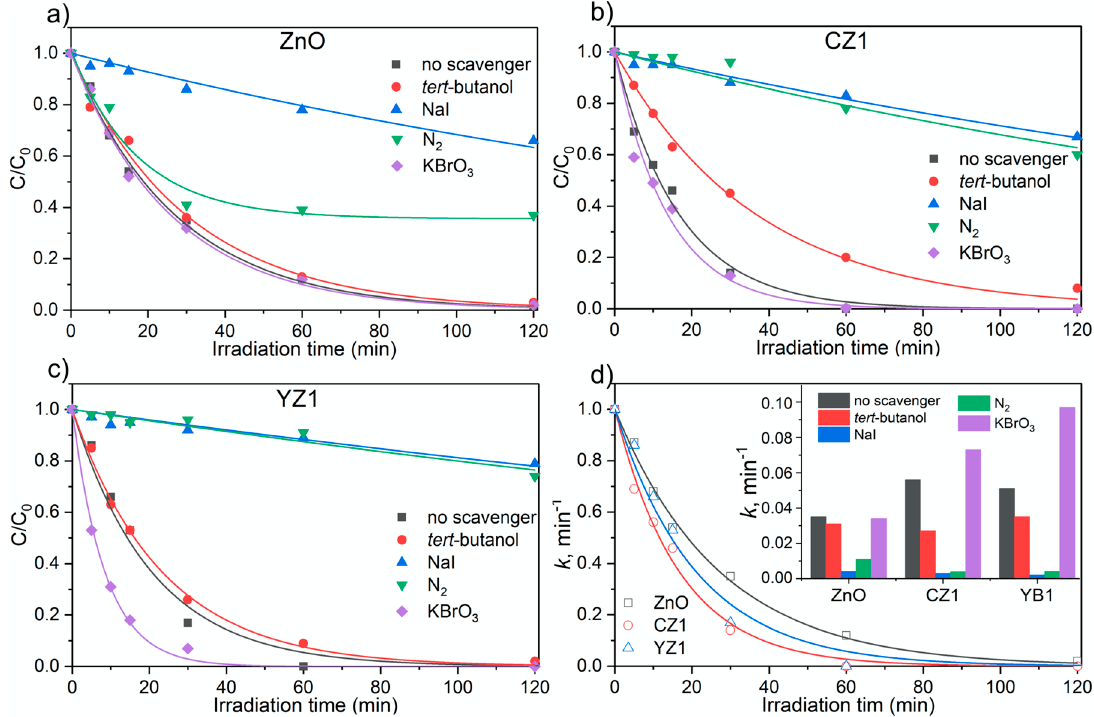
Figure 4. Photodegradation of phenol (20 mg/L) in the presence 200 mg/L of photocatalyst: ( a ) pristine ZnO; ( b ) CZ1; ( c ) YZ1 effect of addition of tert-butanol, NaI and KBrNO 3 (2 mM) on phenol degradation; ( d ) comparison of ZnO, CZ1 and YZ1 without scavengers. Inset: kinetics constant values.